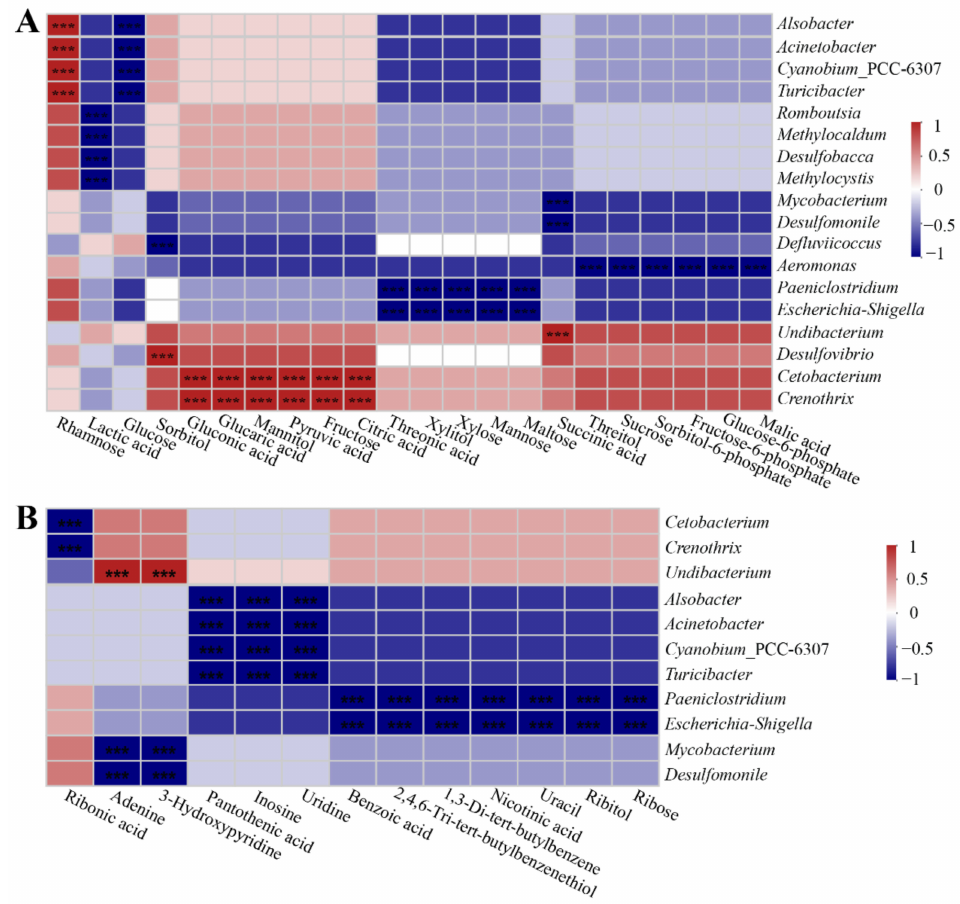
Figure 7. The significant correlation between intestinal main bacterial genera and metabolites. ( A ) The correlation of intestinal bacteria and carbohydrate-related metabolites. ( B ) The correlation of intestinal bacteria and other metabo- lites. The correlation coefficient is represented by different colors (red: positive correlation; blue: negative correlation). * Represents significantly negative or positive correlations (*** p <